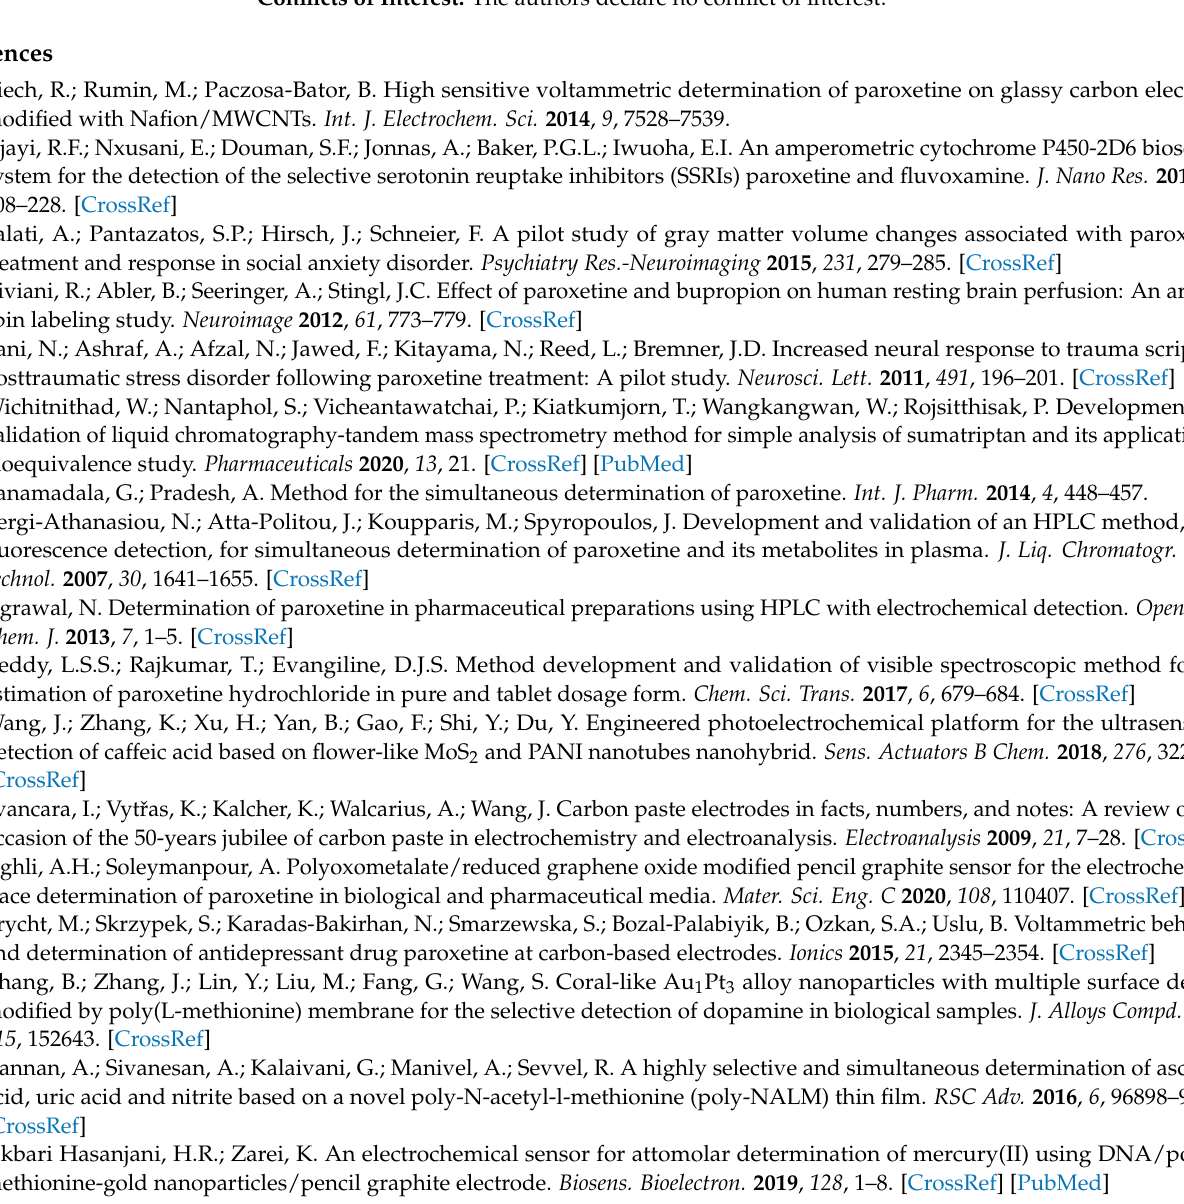
1 mg/mL HAuCl4. Figure S2: Effect of step potential from 0.005 V to 0.035 V on IPRX of 10 µ M PRX at pH 7.5. Figure S3: Effect of accumulation time t.acc from 2 s to 120s on IPRX of 10 µ M PRX at pH 7.5. Figure S4: Effect of accumulation potential from 0–0.05 V on IPRX of 10 µ M PRX at pH 7.5. Figure S5: EDX spectra of AuNPs-GCE (I) and poly ( DL